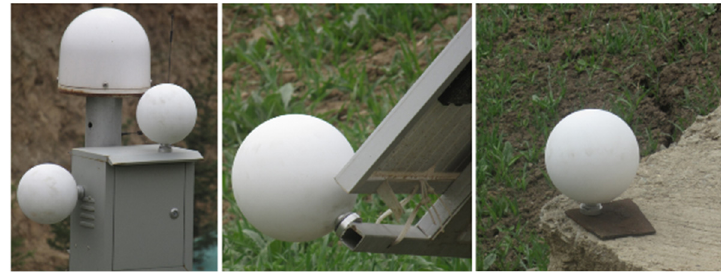
Figure 1. spherical target. Figure 1. Spherical